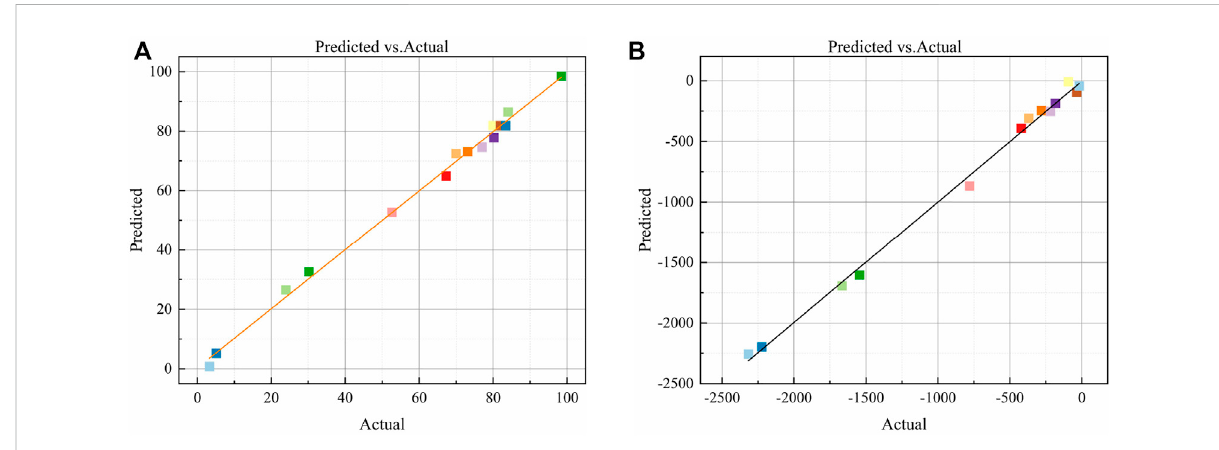
FIGURE 4 Comparative analysis of predicted and experimental values of AASM. (A) Compressive strength and (B) Autogenous